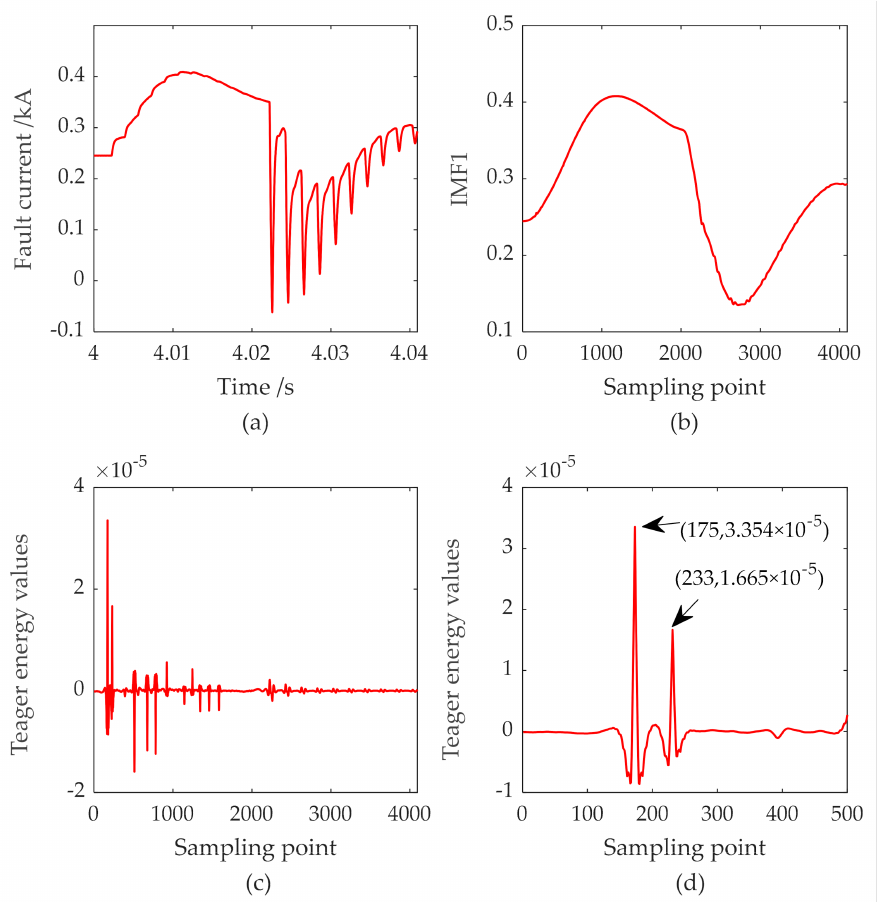
Figure 14. Experimental results of signal extraction and singularity detection for a PN fault at 450 km;